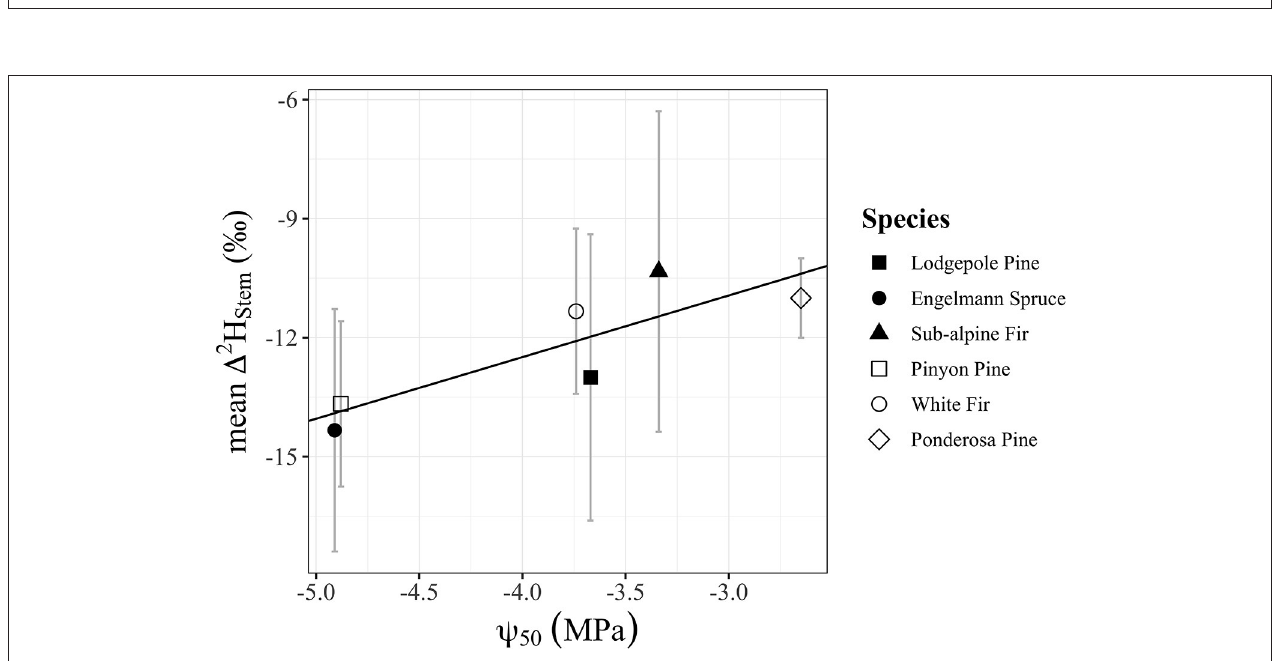
FIGURE 7 | Significant positive relationship ( p = 0.030, R 2 = 0.73) of mean 1 2 H stem for each species ( n = 3 individuals/species) and ψ 50 values for each species from Choat et al. (2012). Points shapes are different for each species with filled in point shapes from the Med Bow location and remaining point shapes from the Campus